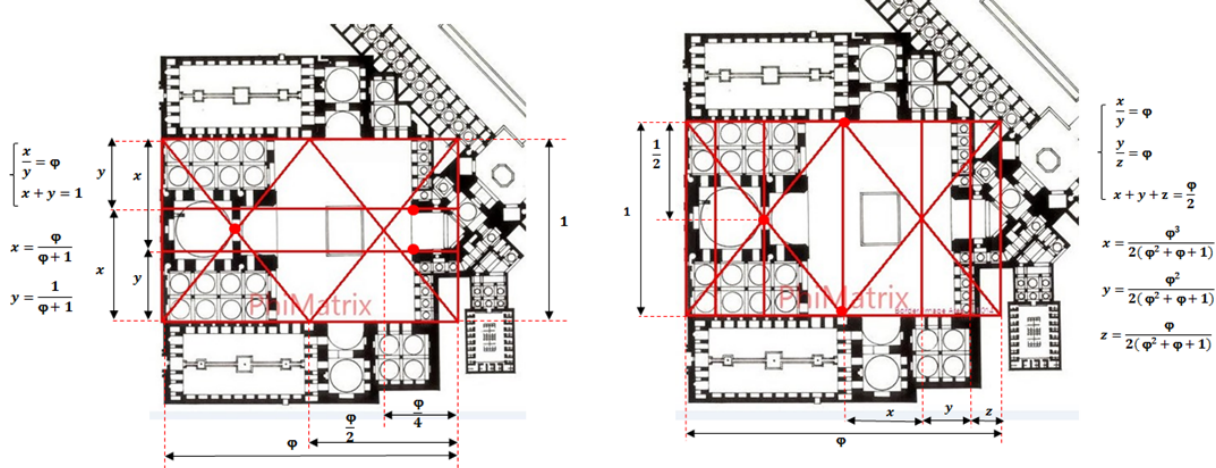
Figure 5: Adaptation of horizontal divisions of the middle golden rectangle with walls of two main entrances